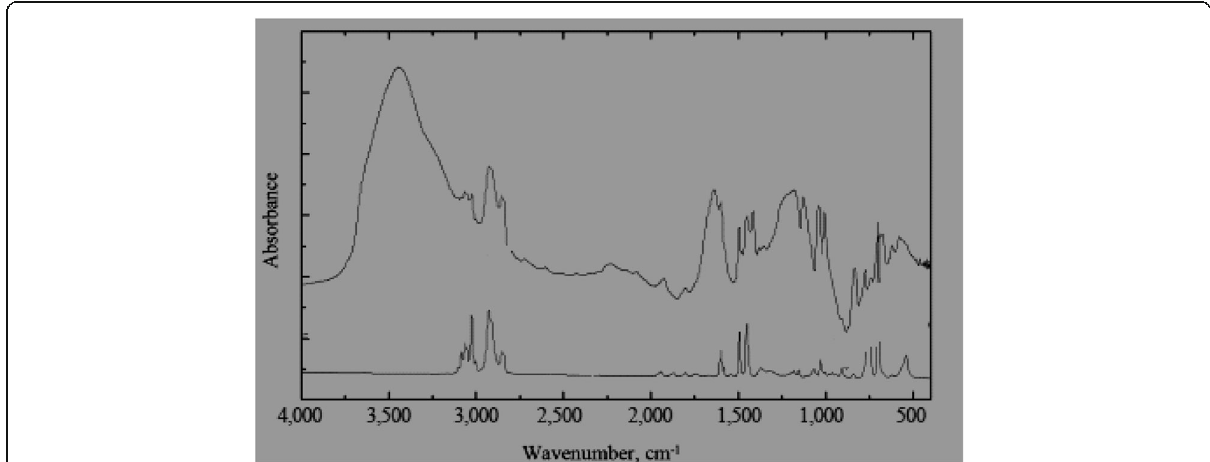
Fig. 3 FT-IR spectra of raw polystyrene foam and synthetic resin